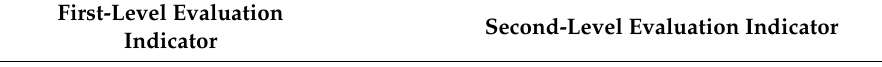
Table 1. Preliminary preset evaluation index set for the post-renewal evaluation of Nantou Ancient City based on literature